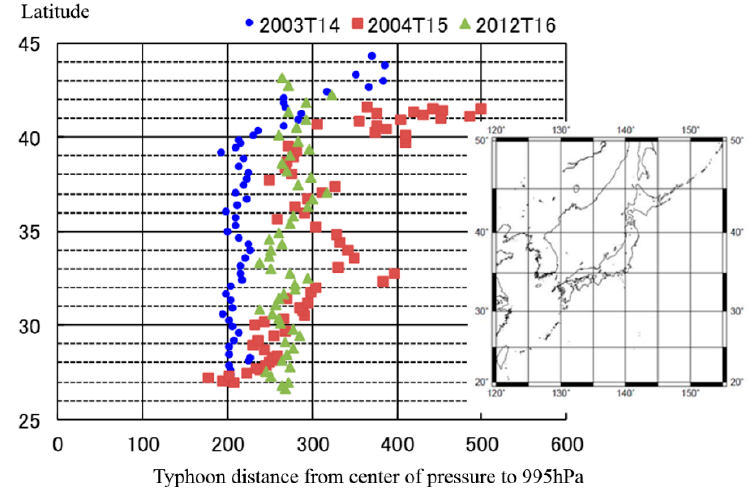
Figure 9. The results of wind direction based on typhoon models.